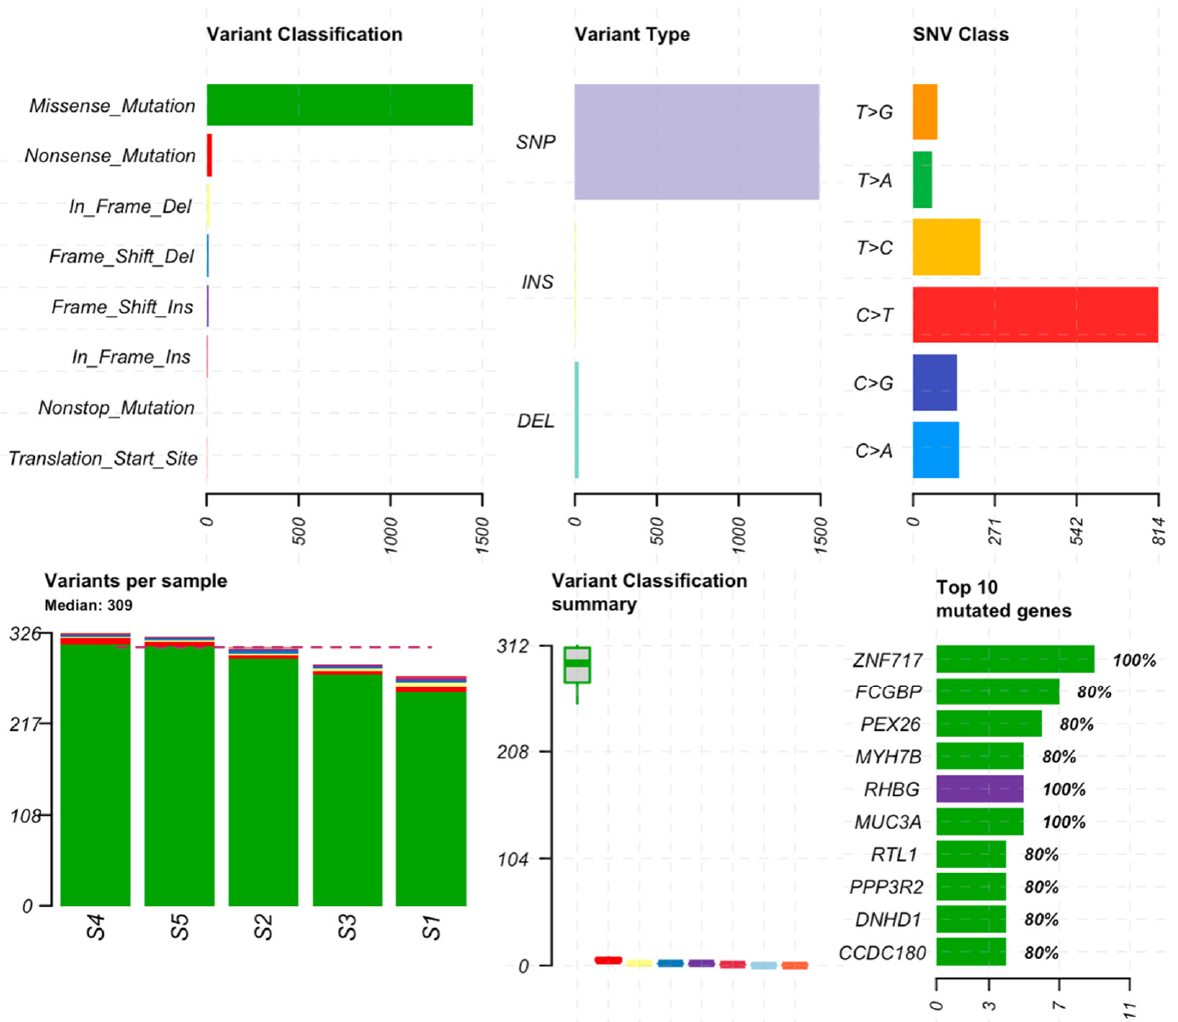
Figure 3. Mutation summary by variant classification, type of variant, and class ( top plots ). The number of mutations per sample, boxplots for variant classification, and the top 10 mutated genes ( bottom plots ). Color representations are green for missense mutations, red for nonsense mutations, purple for frameshift insertions, blue for frameshift deletions, yellow for in-frame deletions, dark pink for in-frame insertions, cyan for nonstop mutations and orange for translation start site. The red dotted line in the variants per sample plot indicates the median of variants for all samples.